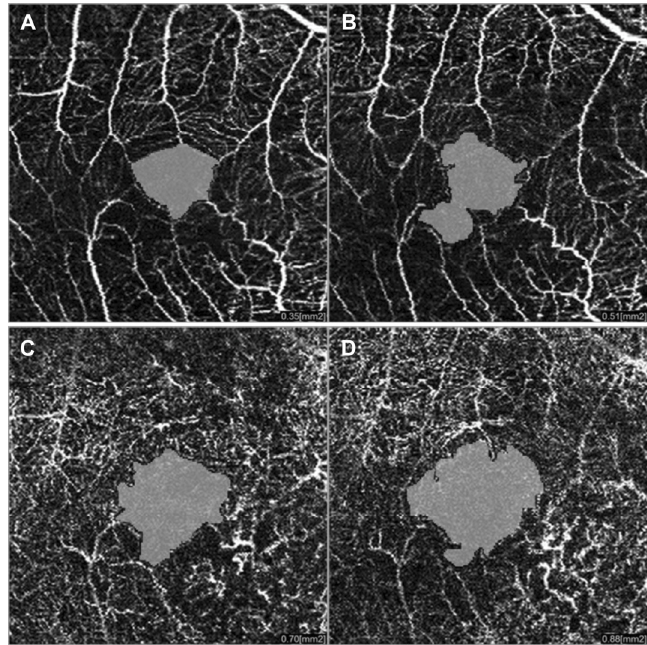
Figure 12. OCTA imaging of the superficial ( A , B ) and deep ( C , D ) plexuses showing foveal avascular zone enlargement in the treated eye ( A , C ) compared to the healthy eye ( B , D ) in a patient treated by brachytherapy because of posterior uveal melanoma.